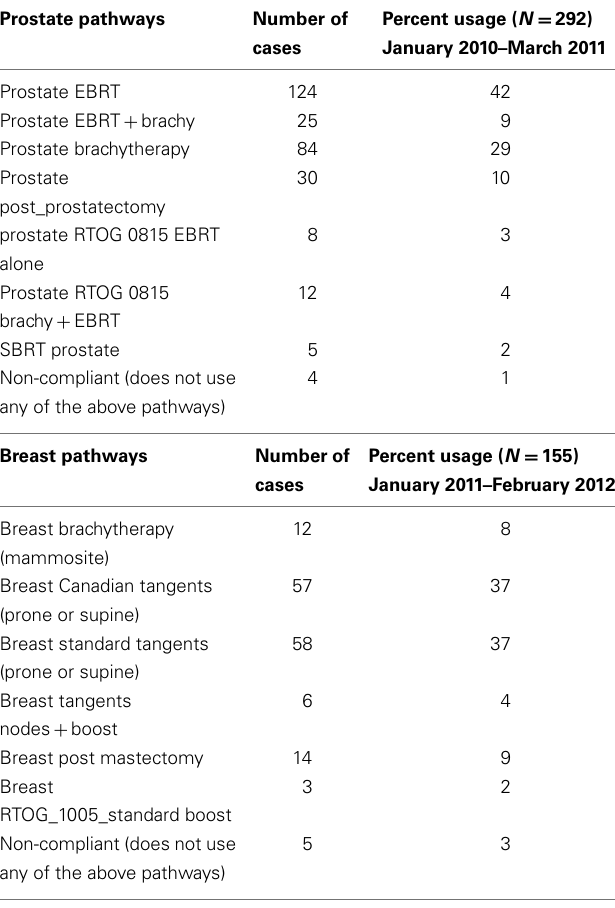
Table 2 | Compliance of prostate and breast cancer